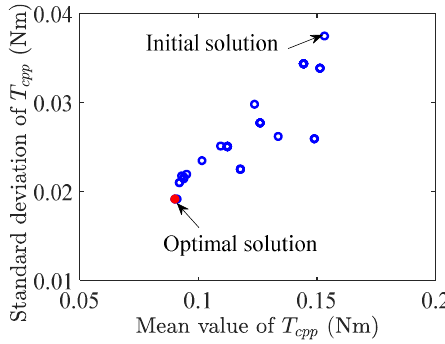
Figure 16. The optimization results.